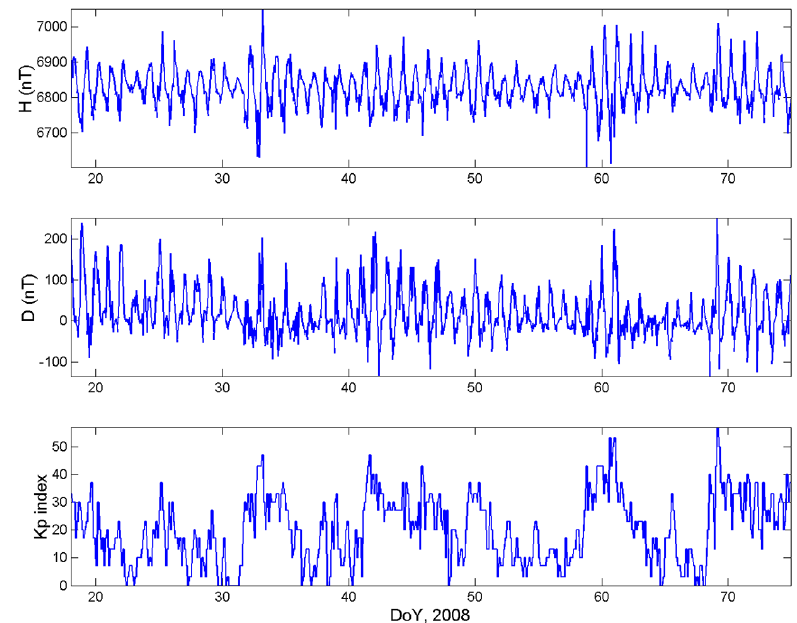
Figure 2. Upper panels: hourly average values of the horizontal component H and D variations at TLD for the whole analyzed time period (from 18 January to 14 March, 2008); lower panel: Kp index.